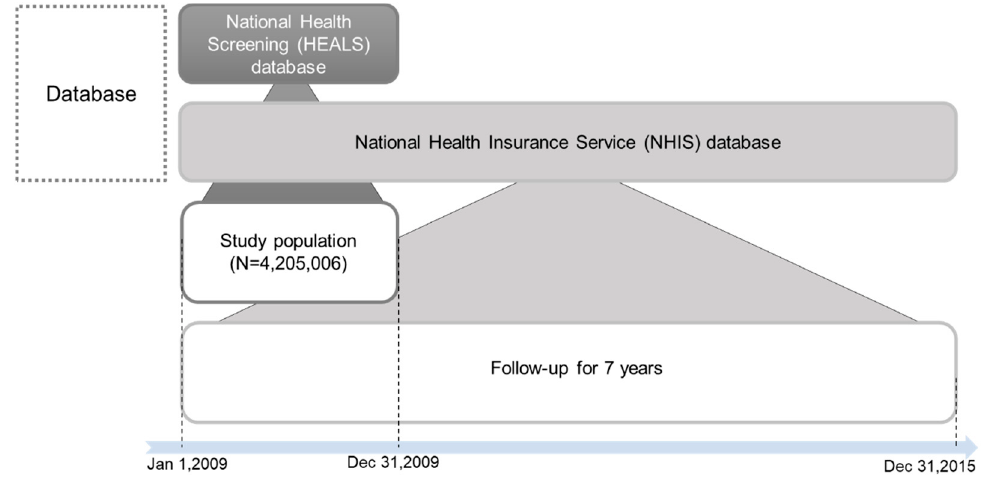
Figure 1. Study Figure 1. Study design.